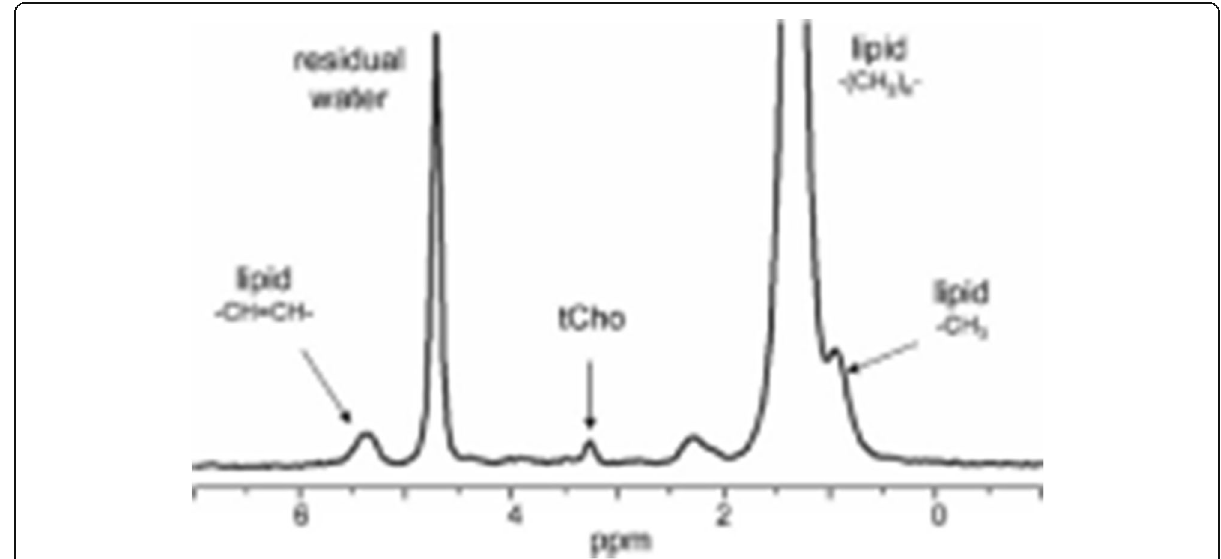
Fig. 17 tCho peak is an indicator of a malignant lesion in breast tissu e[37]